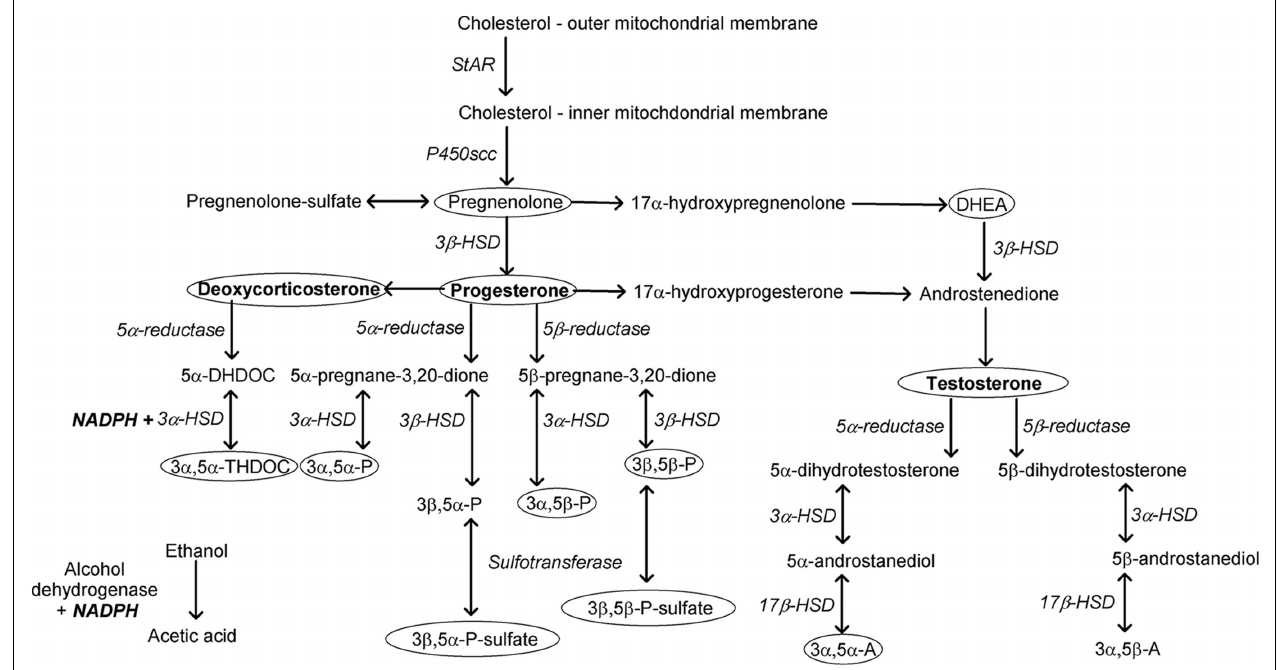
influence sensitivity to the behavioral or endocrine effects of ethanol. Alcohol dehydrogenase and 3 α -hydroxysteroid dehydrogenase require common co-factors. Sulfotransferase enzymes adding a sulfate group rapidly alter the pharmacological activity of neurosteroids. DHDOC, dihydrodeoxycortico- sterone; HSD, hydroxysteroid dehydrogenase; NADPH, nicotinamide adenine dinucleotide phosphate-oxidase; NADH, nicotinamide adenine dinucleotide; scc, side-chain cleavage; StAR, steroidogenic acute regulatory